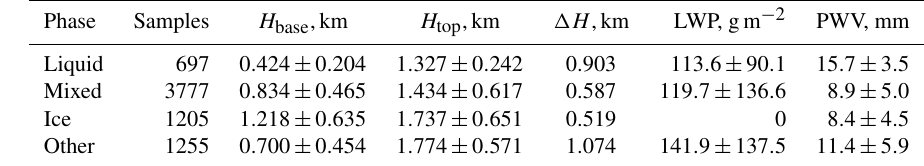
Table 4. Liquid, mixed, ice and other phases of cloud properties within the single-layered, low-level clouds.